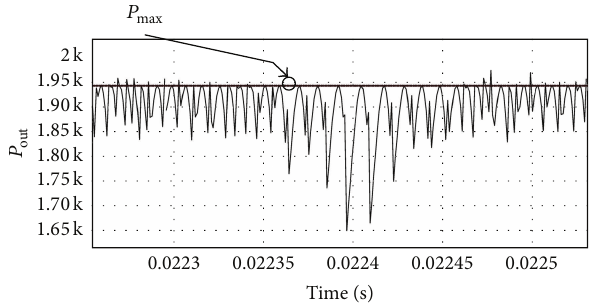
and 𝑃 max when using P&O. out